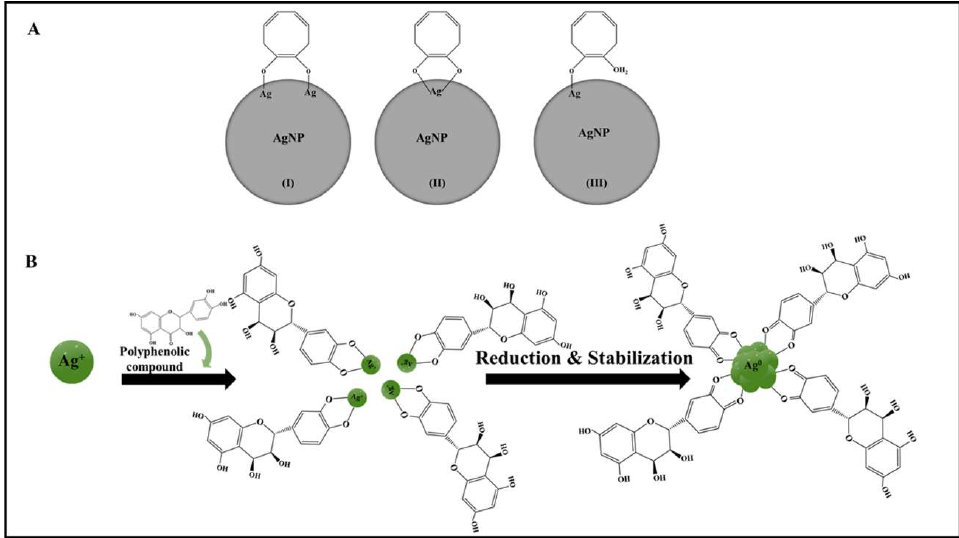
Figure 8. Schematic illustration of mechanism behind polyphenol in metallic nanoparticle synthesis, ( A ) catechol binding mechanism with silver nanoparticles, ( B ) silver nanoparticle synthesis were reproduced with permission (115).